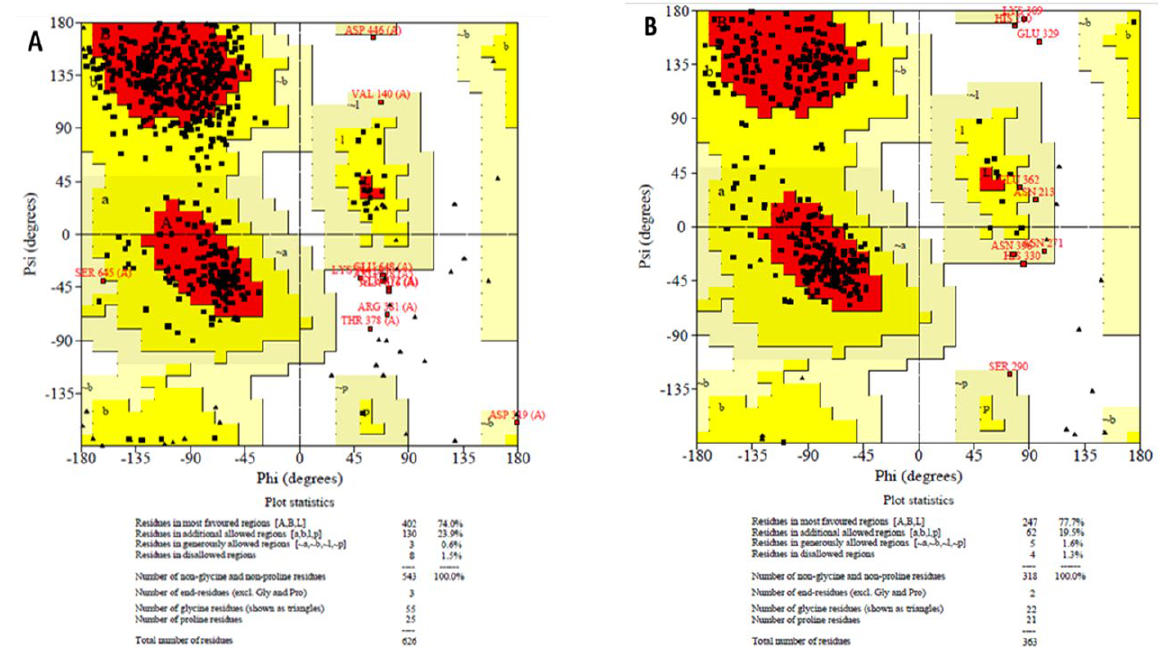
Figure 8. Ramachandran plot of modelled trypanosomal sialidase ( A ) and PLA 2 ( B ) showing amino acid residue regions.